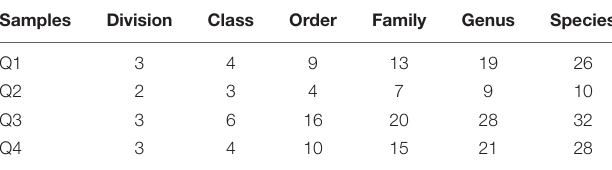
TABLE 2 | Phytoplankton diversity at different levels in the four basins.